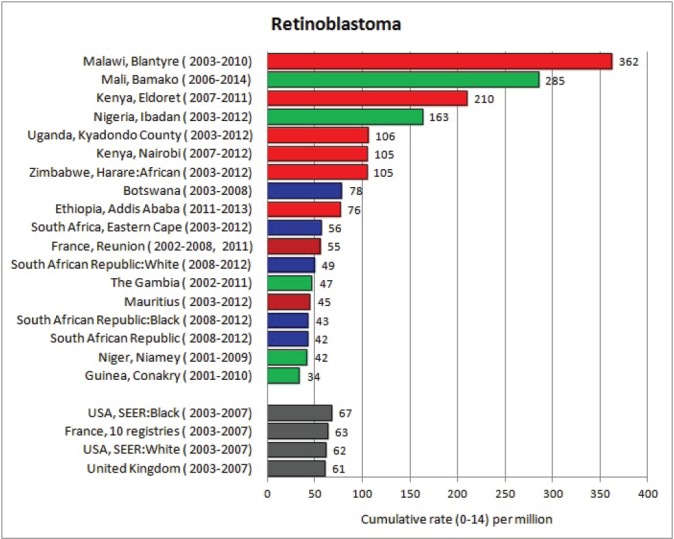
Cumulative (0–14) incidence rate – retinoblastoma.